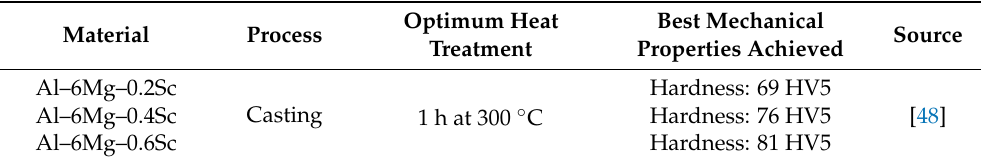
Table 2. Heat treatment strategies for AlMgSc(Zr) alloys fabricated by different processes and the achieved mechanical properties.